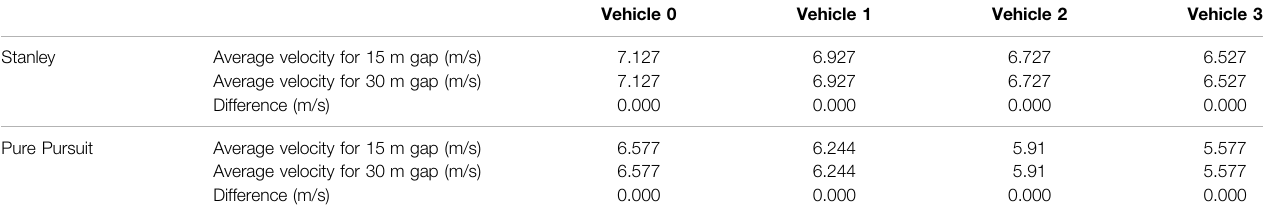
TABLE 5 | Average velocity per vehicle using for different gap